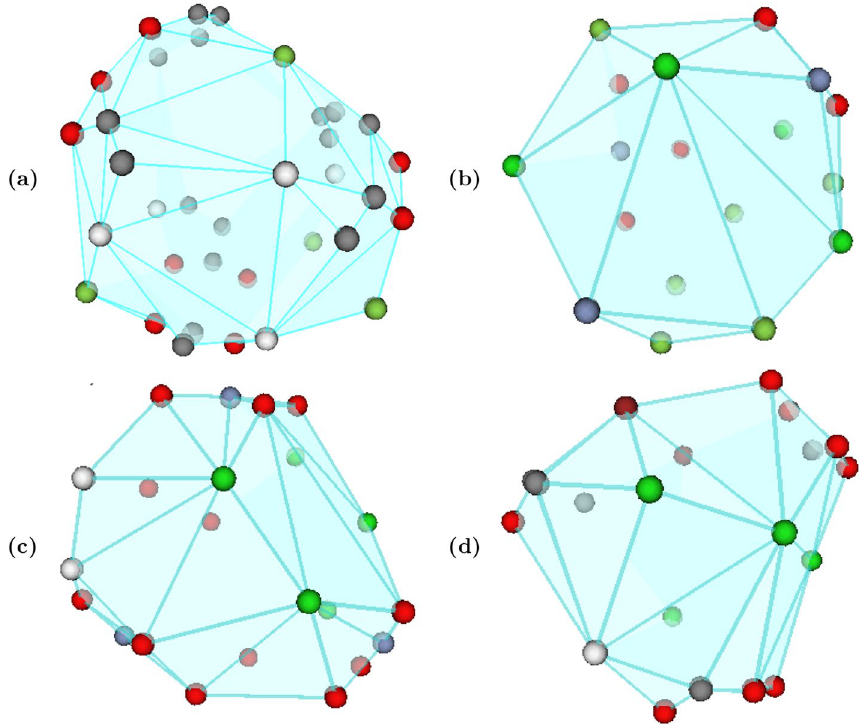
Figure 5. Correlating void structure to MOF property. ( a ) str-m4-o14-acs-sym-8 ( b ) str-m4-o1-o22-acs- sym-94 ( c ) str-m4-o1-o24-acs-sym-96 ( d ) str-m4-o1-o24-acs-sym-165. The representative cycles of voids corresponding to the void most correlated with the CO 2 Henry’s coefficient in example MOFs with high CO 2